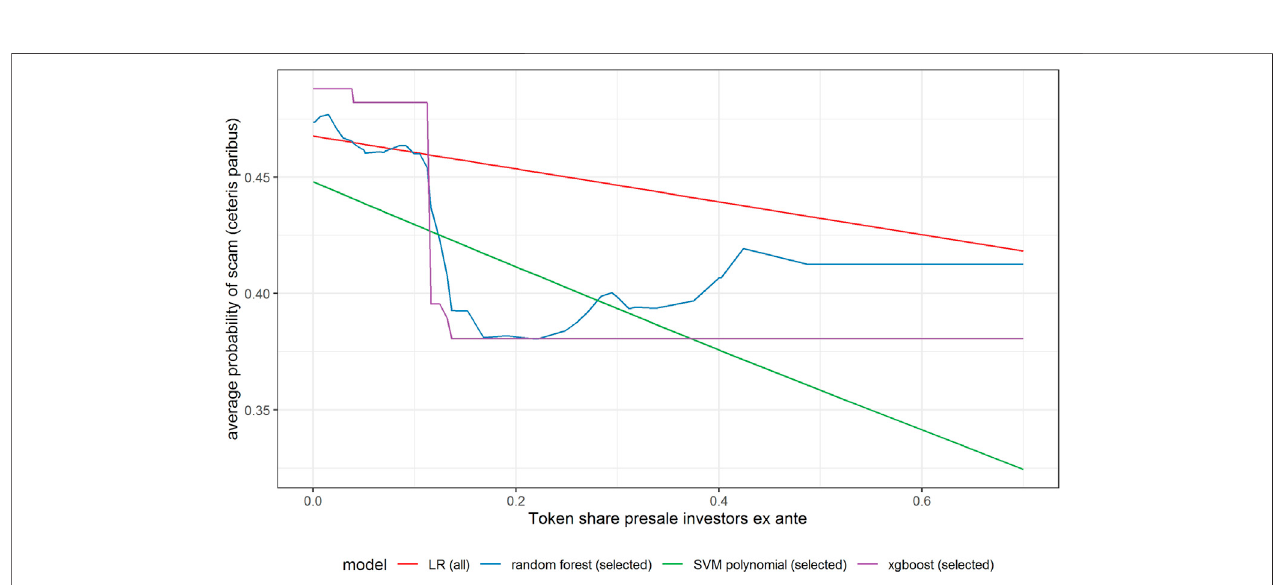
FIGURE 11 | Partial dependence plot for variable indicating the share of tokens for the investors in presales (ex-ante).